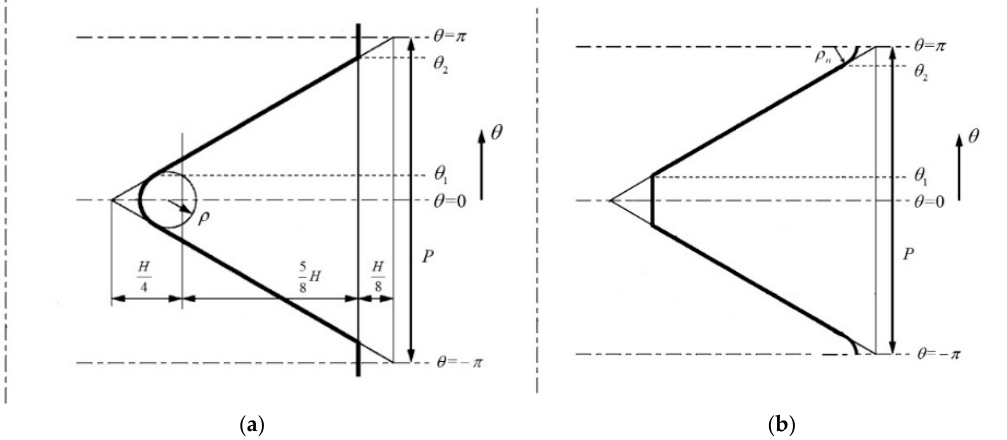
Figure 5. ( a ) The external thread profile. ( b ) The internal thread profile (The thread pitch P is 1.25 mm, the radius ρ n is 0.07 mm, the thread height H is 1.08 mm, and the radius ρ is 0.14 mm). The thread is applied at the nut, and the diameter of holes on the jointed plates is larger than that of the screw [16,28]. The established high-quality models of the bolt and nut are shown in Figure 6. The mesh of the bolt cross section and the hole of the nut are not symmetric with respect to the axis due to the thread lead angle of 2.8473°.